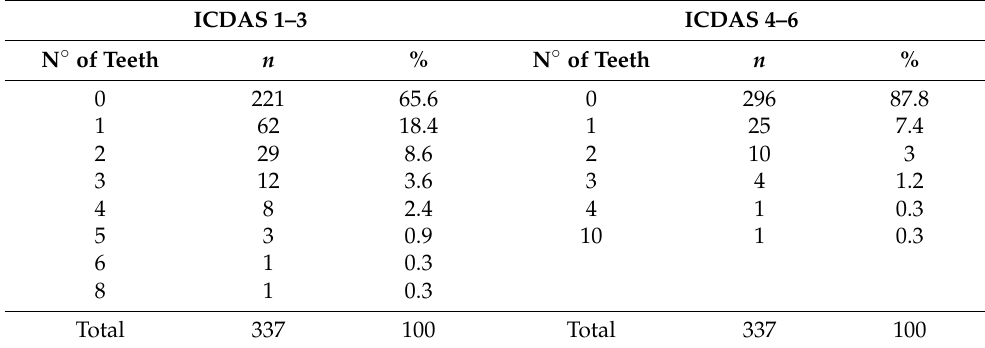
Table 4. Participants with their ICDAS caries codes and number of teeth